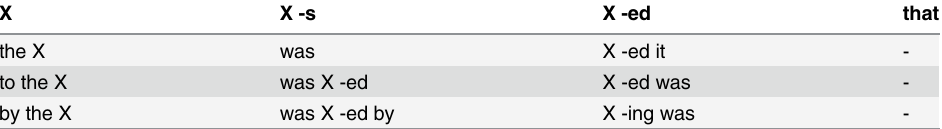
Table 8. Group of words that compose the sentences of the database used for this experiment. The X represents a closed-class word. In case of ambiguities, the system is trained to use the largest groups. X X -s X -ed that the X was X -ed it - to the X was X -ed X -ed was - by the X was X -ed by X -ing was -